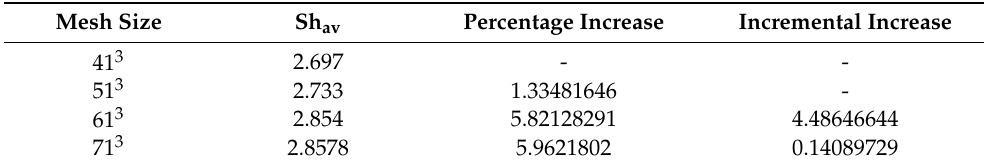
Table 1. Grid sensitivity test for case 0, N = 0 and Ra = 10 4.